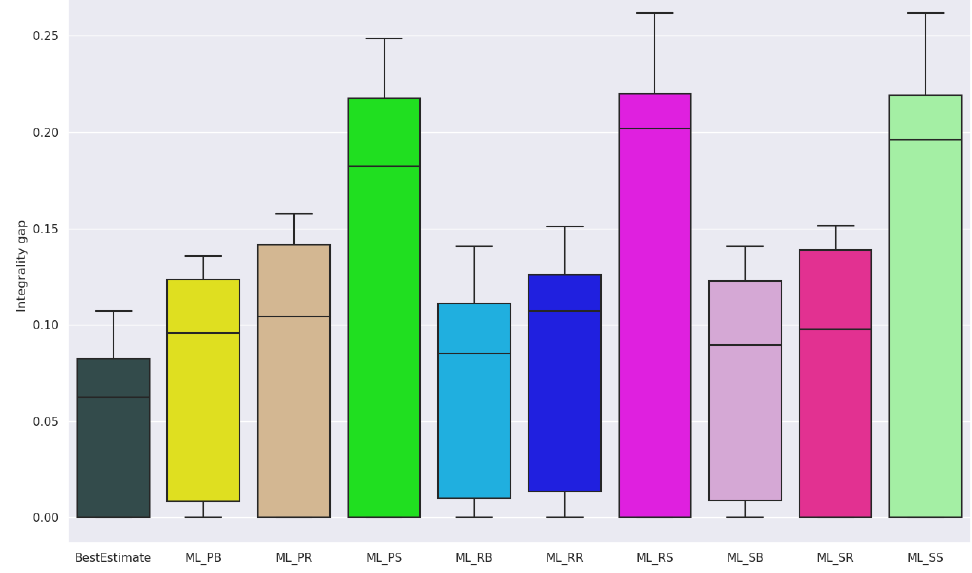
Figure 7. Hard set cover instances: integrality gap of each node selection